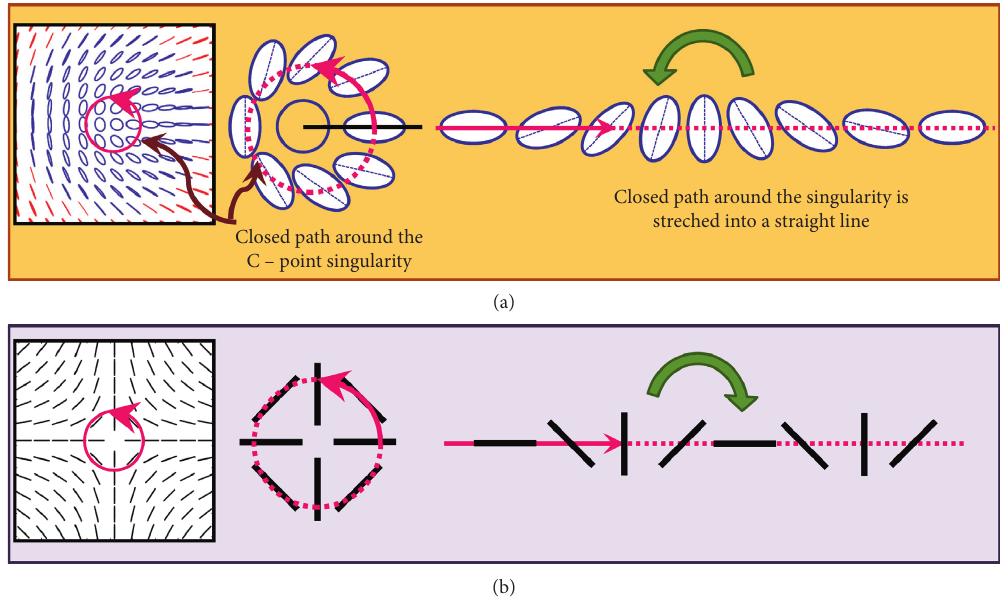
Figure 4: Rotation of the azimuths of the surrounding SOP states around a singular point: (a) a left-handed positive index C-point with I � 1/2; (b) a negative index V-point with η � − 1. The pink arrow denotes the sense of traversal of a closed path around the singularity, i.e., C anticlockwise. The green arrow depicts the sense of rotation of the major axes of ellipses (plane of polarization of linearly polarized state in case of a V-point) around the